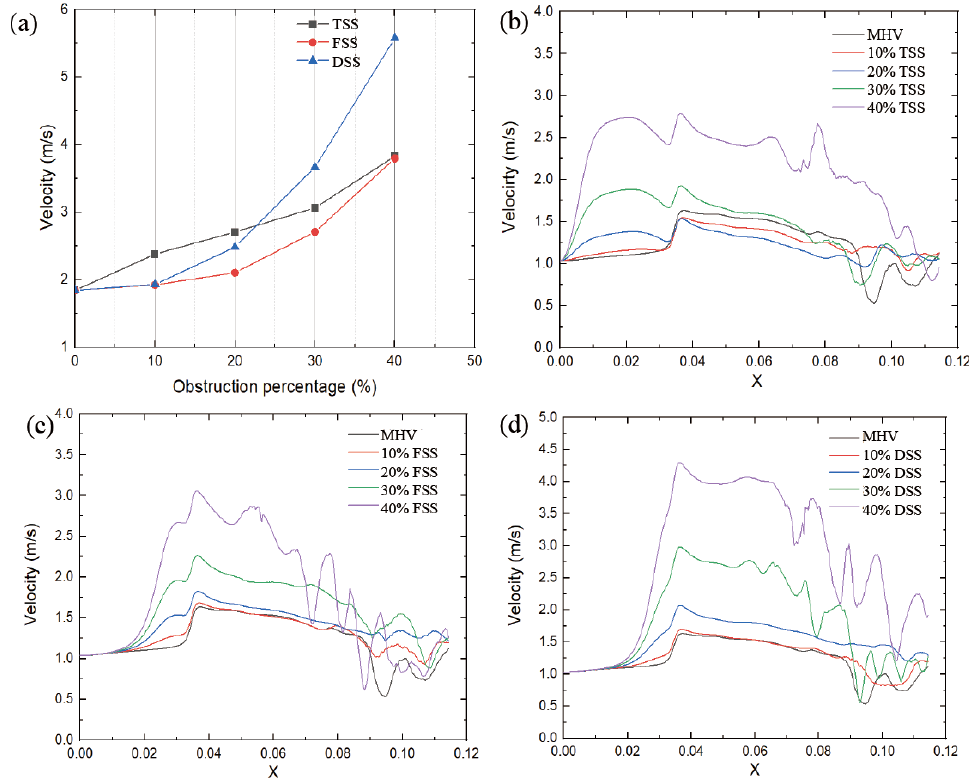
Figure 8. Velocity comparison of ( a ) obstruction vs. peak velocity and velocity change along the centerline ( b ) TSS, ( c ) FSS, ( d ) DSS ( t = 0.2 s).